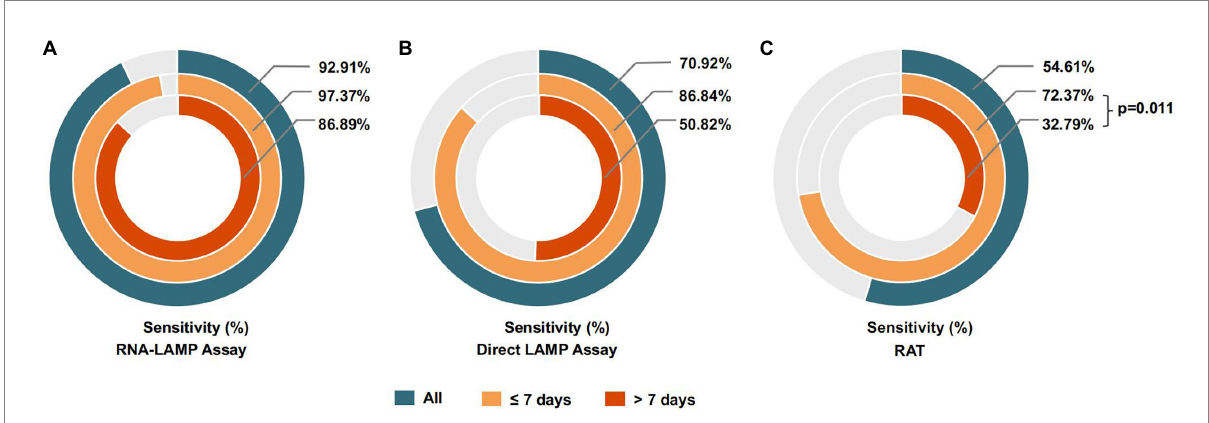
FIGURE 4 (A) The sensitivity of the RNA-LAMP assay among samples collected in different phases of COVID-19. (B) The sensitivity of the direct LAMP assay among samples collected in different phases of COVID-19. (C) The sensitivity of the RAT among samples collected in different phases of COVID-19.